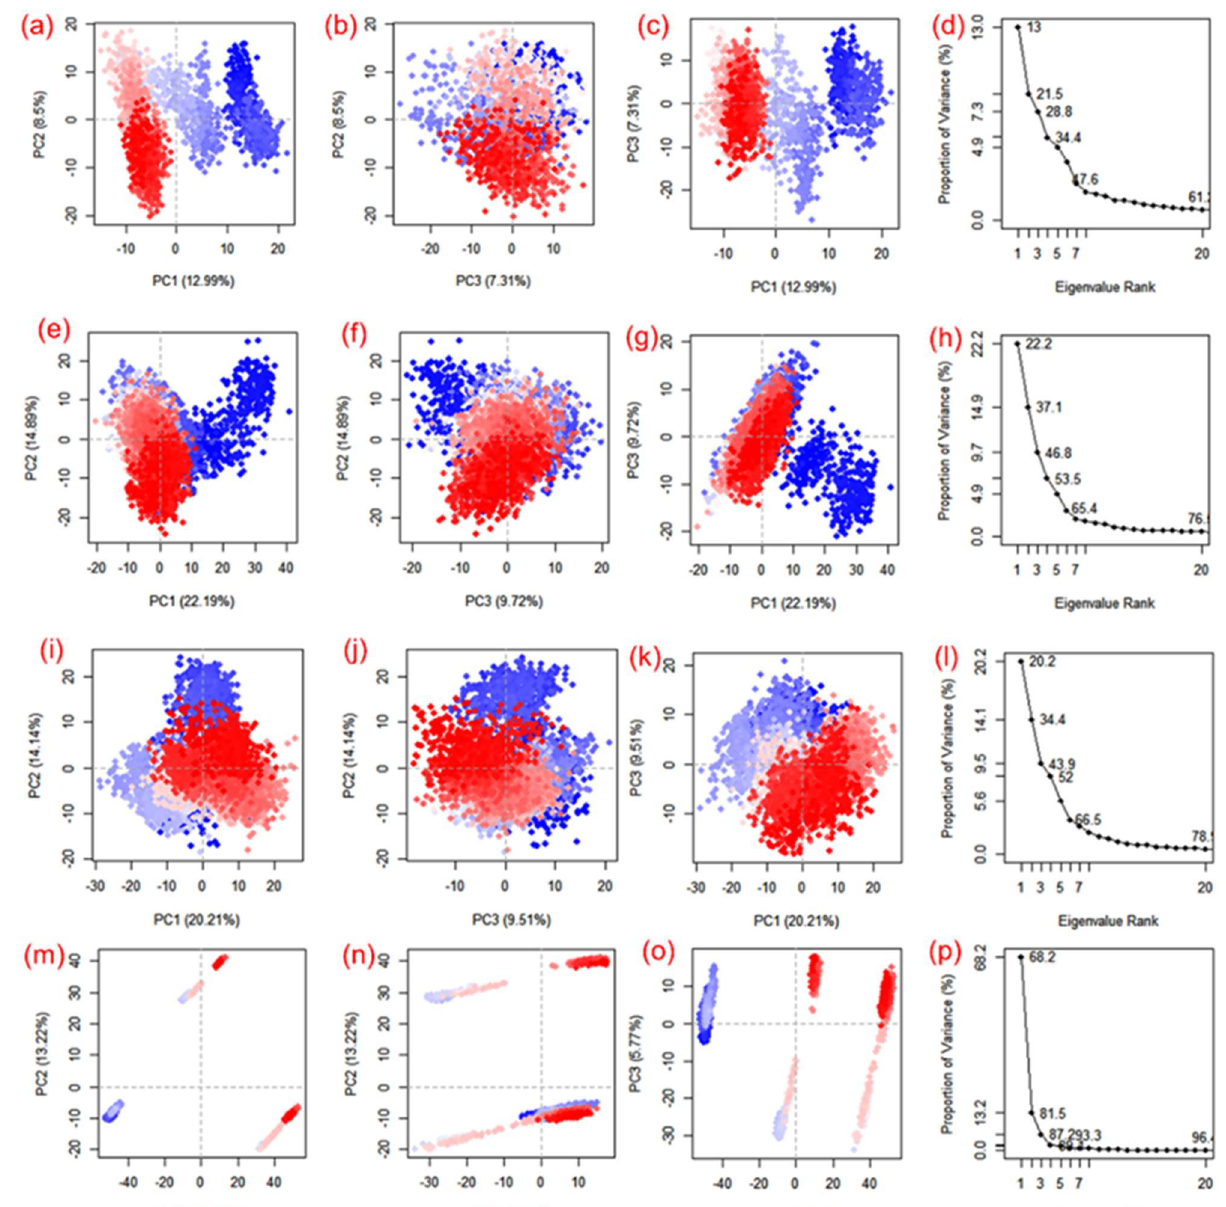
Figure 6 . PCA analysis of SARS-CoV-2 docked simulated MD trajectories with cassameridine ( a – d ), laetanine ( e – h ), litseferine ( i – l ), and cassythicine ( m – p ). Each direction’s logged deviations in the residue location are categorised by the analogous eigenvalue’s total percentage of mean square displacements (PCs). Periodic jumps between the structural conformations taken from the 100 ns simulation trajectories are visible in the continuous colour change from blue to white to red.